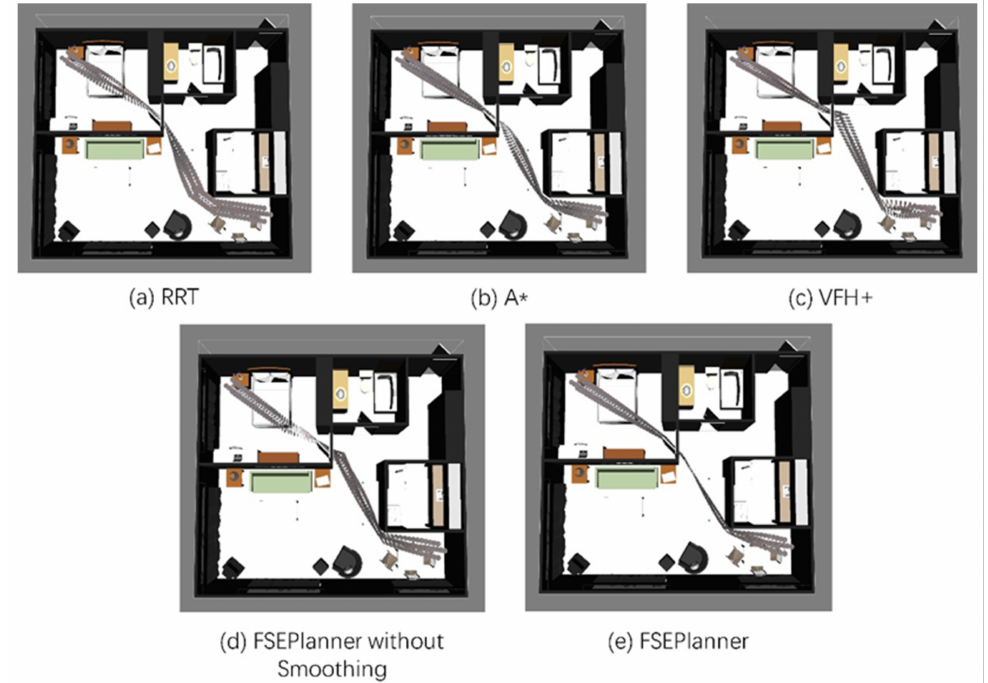
Figure 17. Trajectories of five path planning simulation in apartment environment visualization